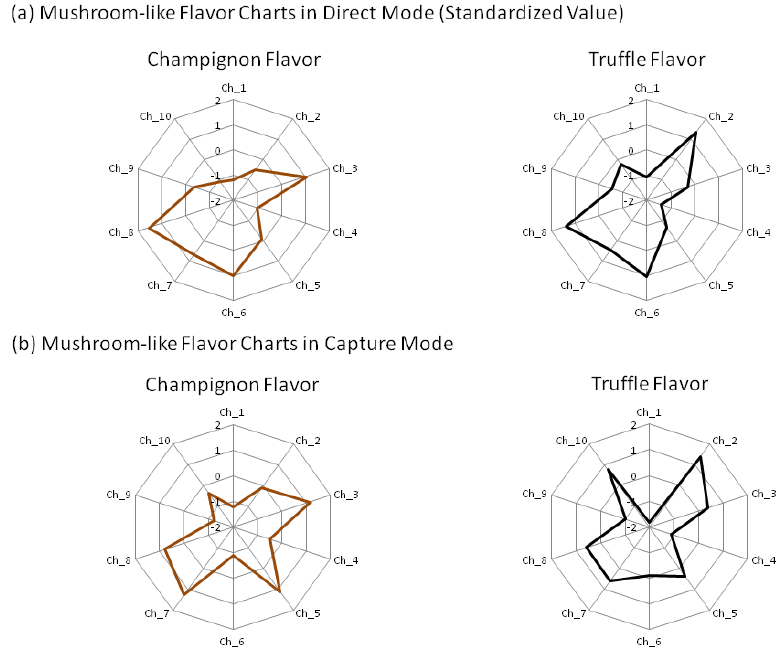
Figure 7. Standardized values for two types of mushroom flavors, champignon flavor and truffle flavor in ( a ) Direct mode and ( b ) capture mode.